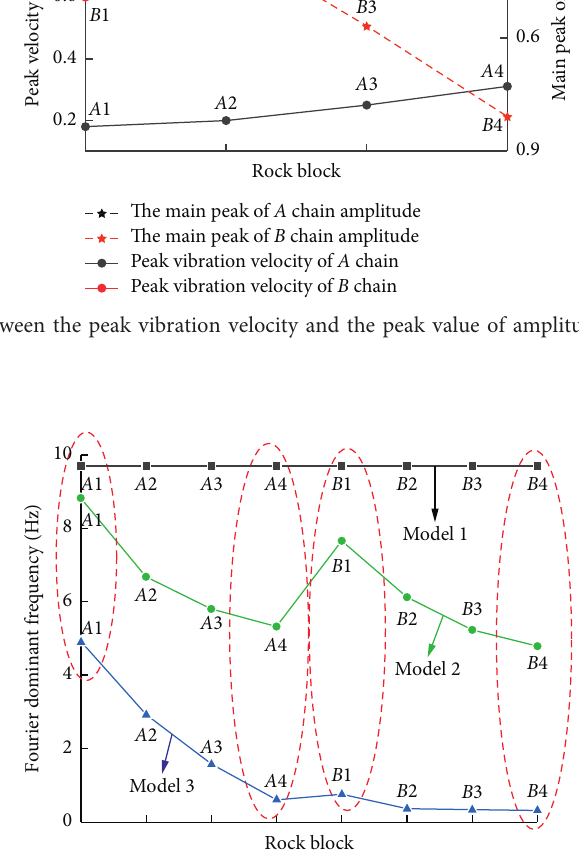
Figure 17: Comparison of Fourier dominant frequency of each